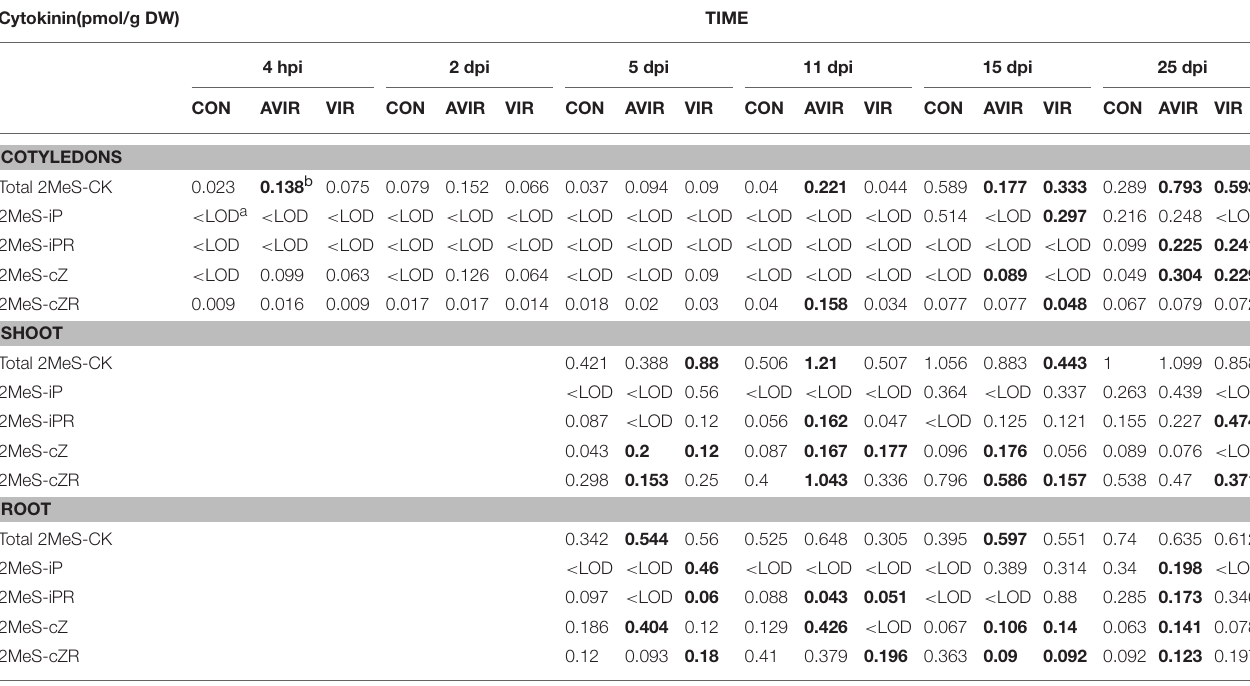
TABLE 2 | 2-Methylthio-cytokinin content in Pisum sativum cotyledons, shoots and roots following either mock inoculation of seeds (CON), or inoculation with avirulent strain 589 (AVIR) or virulent strain 602 (VIR) of Rhodococcus fascians . Cytokinin(pmol/g